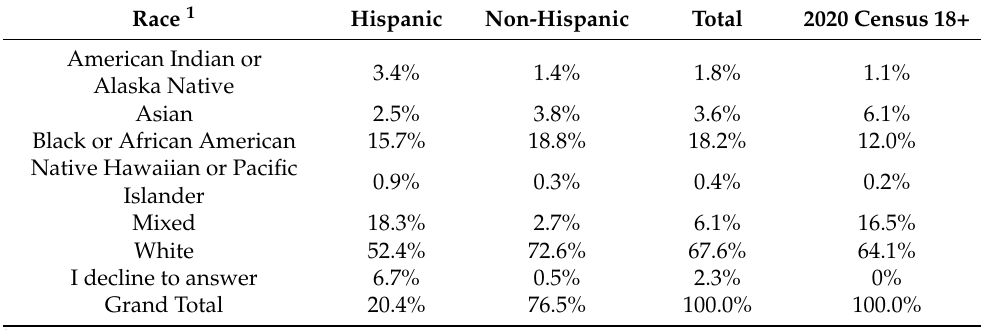
Table 1. Racial and ethnic makeup of sample ( n = 7532).